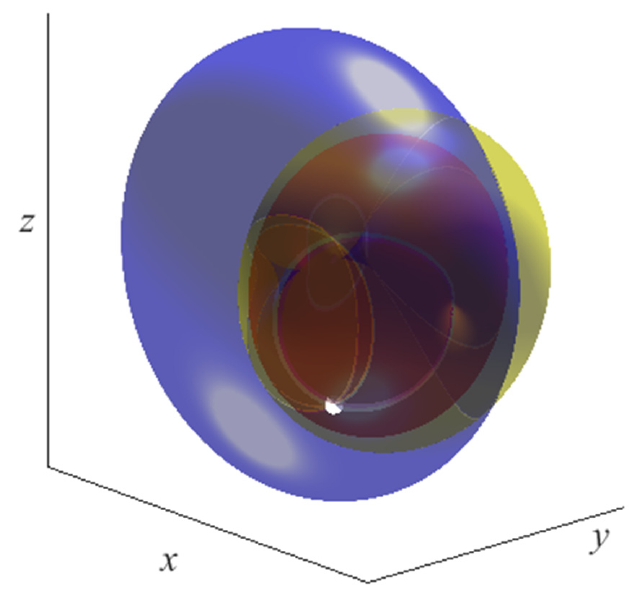
Figure 7. Spatial location distribution-based OPNAV results.